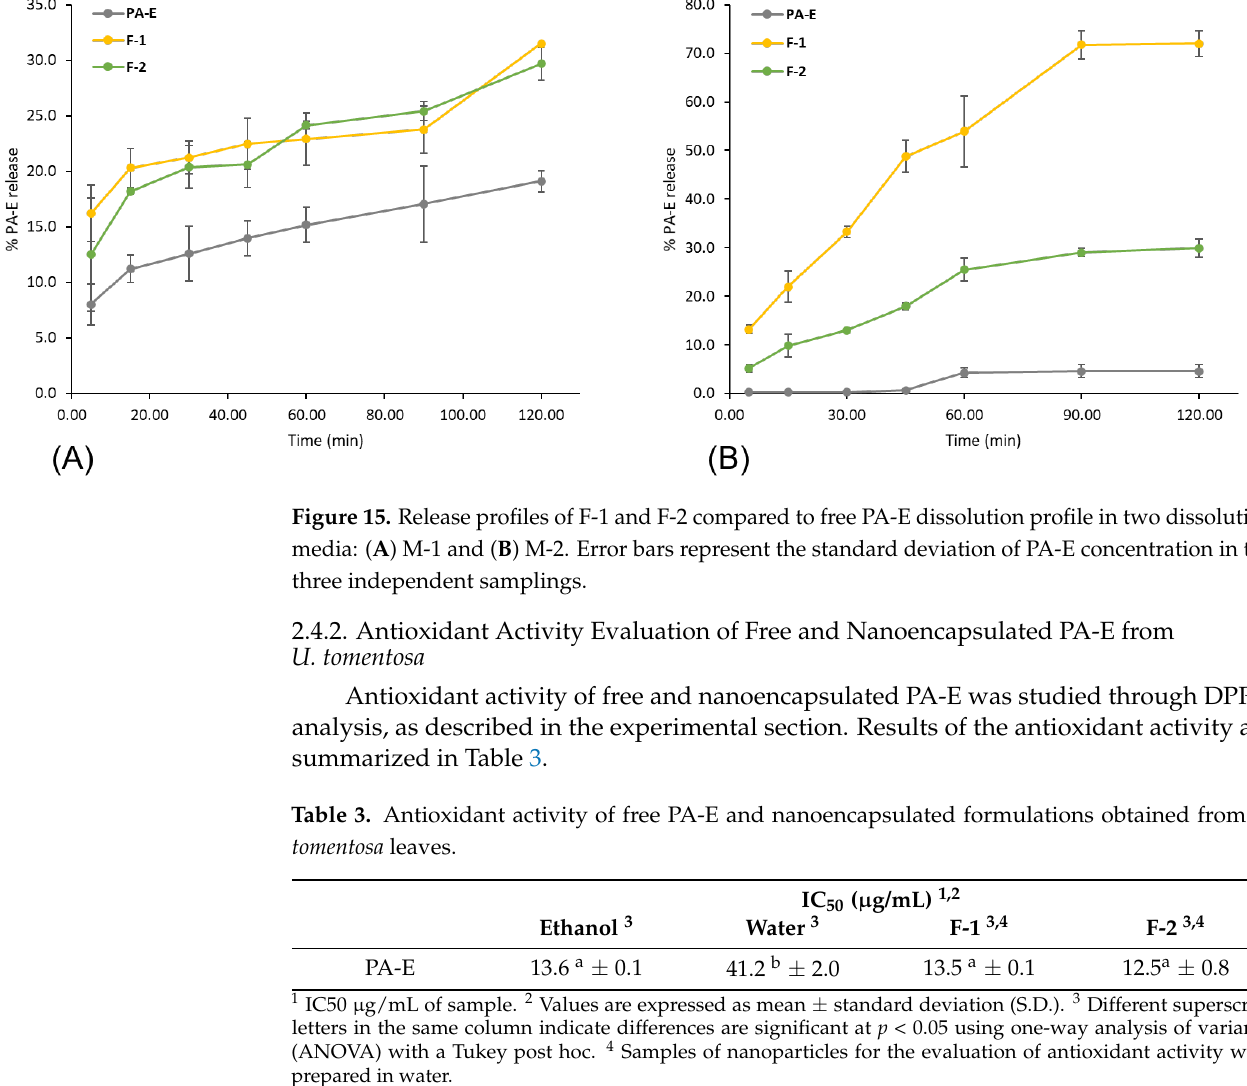
Table 3. Antioxidant activity of free PA-E and nanoencapsulated formulations obtained from U. tomentosa leaves.